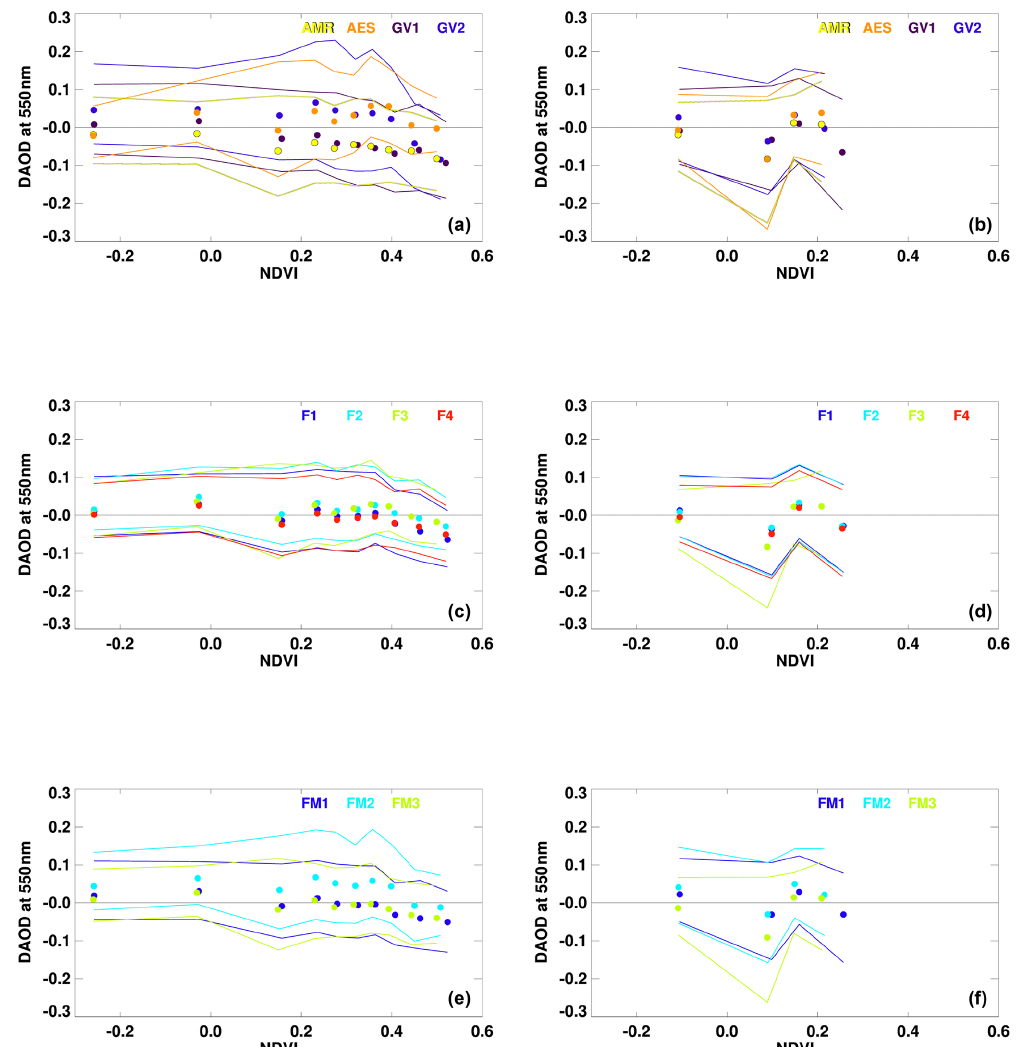
Figure 7. Difference between the (a, b) respective satellite, (c, d) ensemble mean, and (e, f) MLE and AERONET AOD in terms of NDVI during the KORUS-AQ (a, c, e) and the EMeRGe (b, d, f) campaigns. Each point and solid line represents the median and 1 σ (16th and 84th percentile) of 500 (for the KORUS-AQ) and 400 (for the EMeRGe) collocated data points in terms of NDVI values, respectively. Colors represent different aerosol